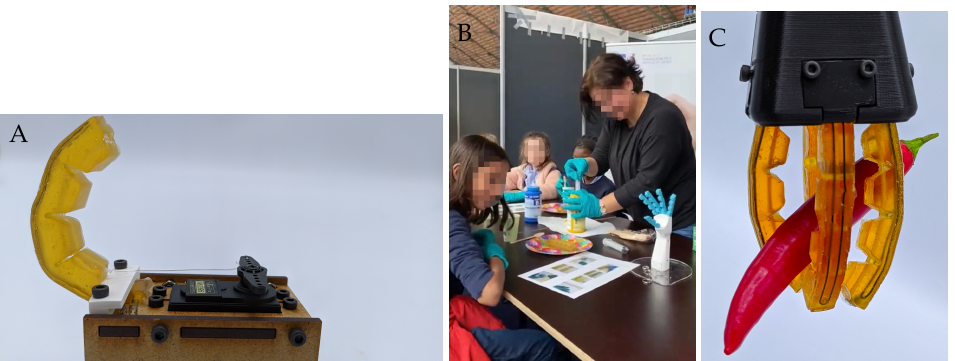
Figure 1. Result of the tutorial and workshop. ( A ): The self-healing soft finger with embedded sensor complete with the test set-up is the end goal of this tutorial. ( B ): The tutorial is easily adapted for use with commercial polymers, and can even be taught to children in an adapted version. No sensor was embedded in this case, and actuation was done manually. ( C ): The fingers made during the tutorial can for example be used in a gripper to pick up